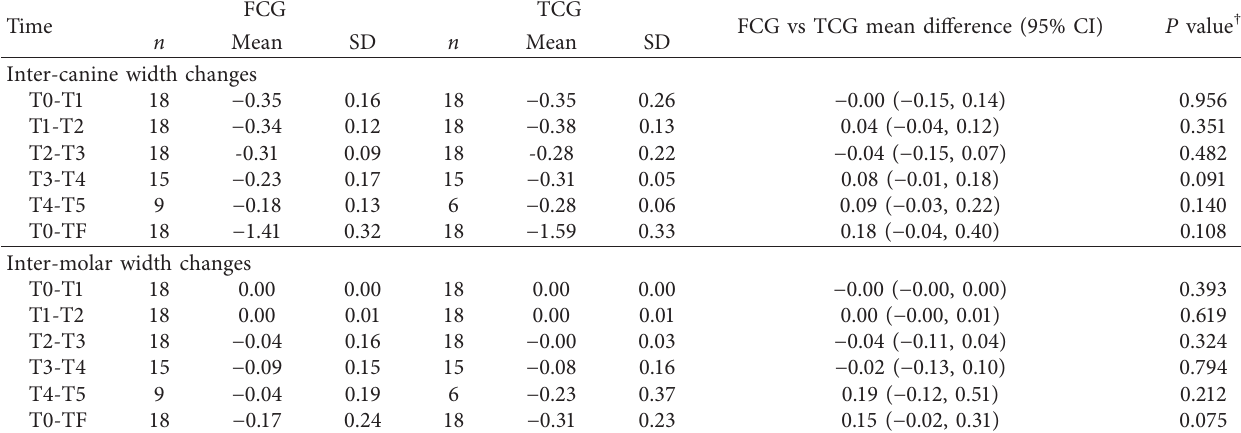
Table 4: Descriptive statistics of the inter-canine and inter-molar width changes (mm/month) as well as the P values of significance tests. Time